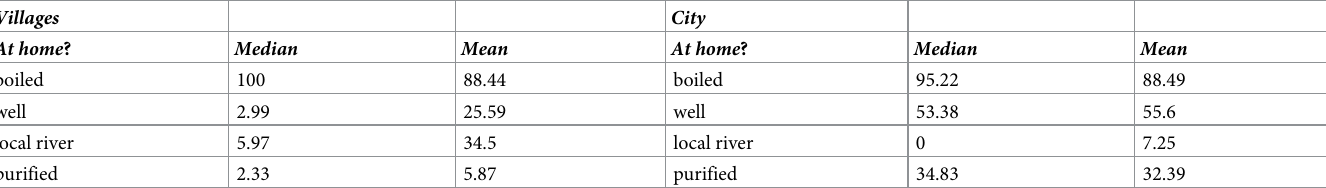
Table 7. Sources of water acceptable to drink and sources used at home, with responses classified by school location.